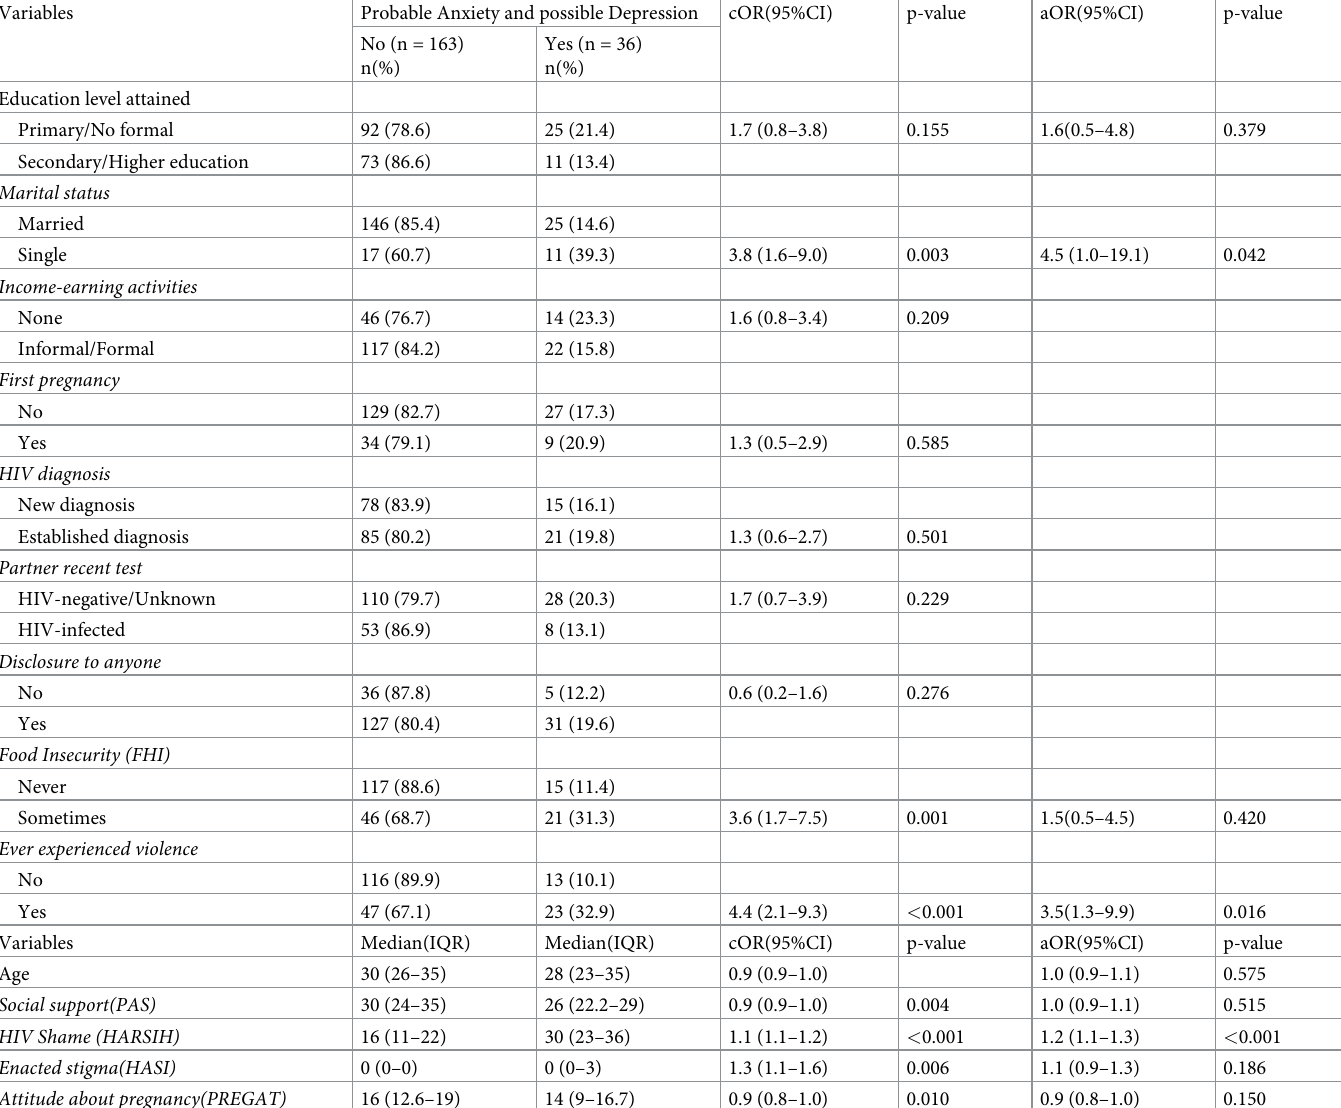
Table 4. Bivariate and multivariate analysis of factors associated with comorbidity of depression and anxiety (n = 199). Variables Probable Anxiety and possible